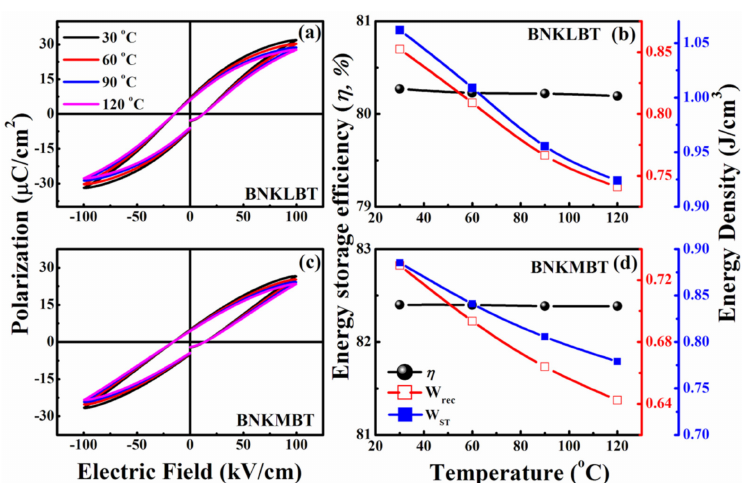
Figure 6. Temperature-dependent P − E analysis ( a ) for the BNKLBT ceramic and ( c ) for the BNKMBT ceramic. Energy density and energy storage efficiency as a function of temperature ( b ) for the BNKLBT ceramic and ( d ) for the BNKMBT